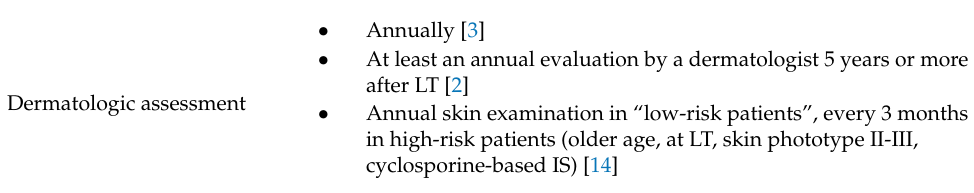
Table 1. Proposals for screening: selected recommendations from the literature